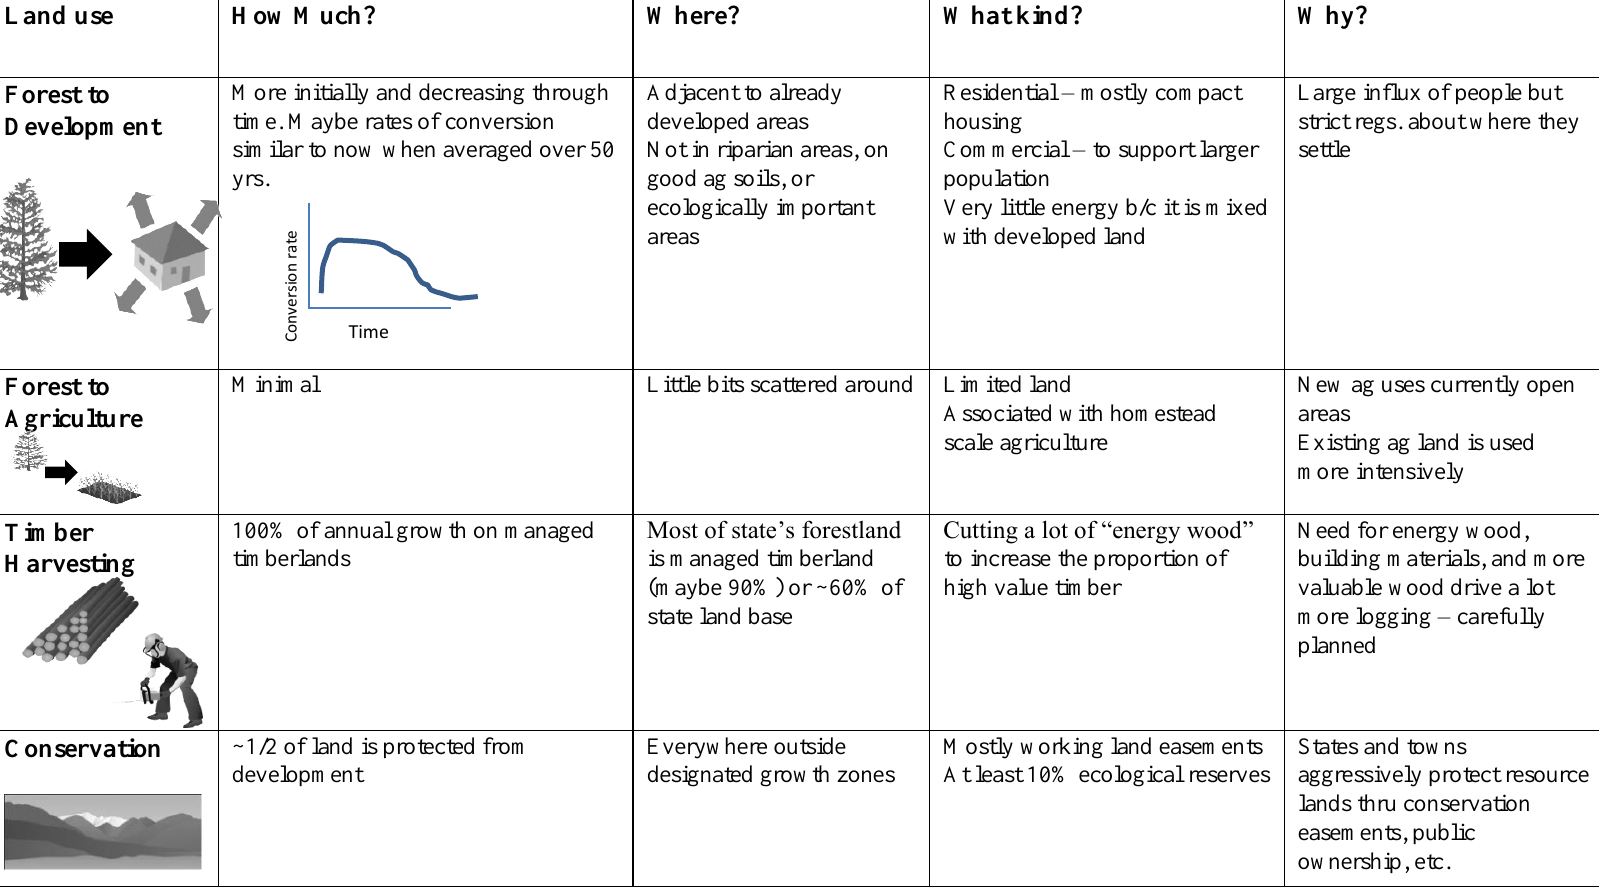
Table A2.2. Scenario 2: Little Switzerland Land use How Much? Forest